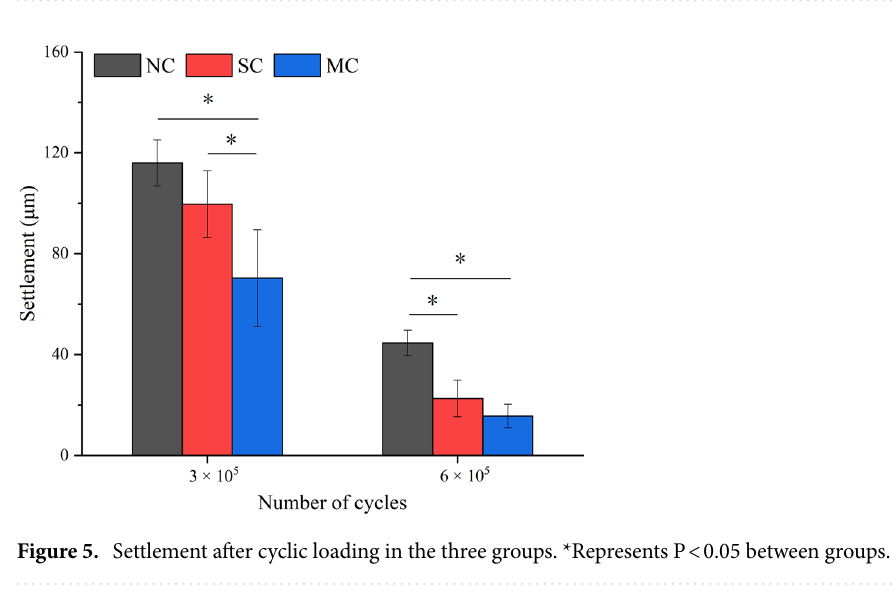
Figure 4. RTVs (T 3 and T 6 ) after cyclic loading in the three groups. *Represents P < 0.05 between groups.